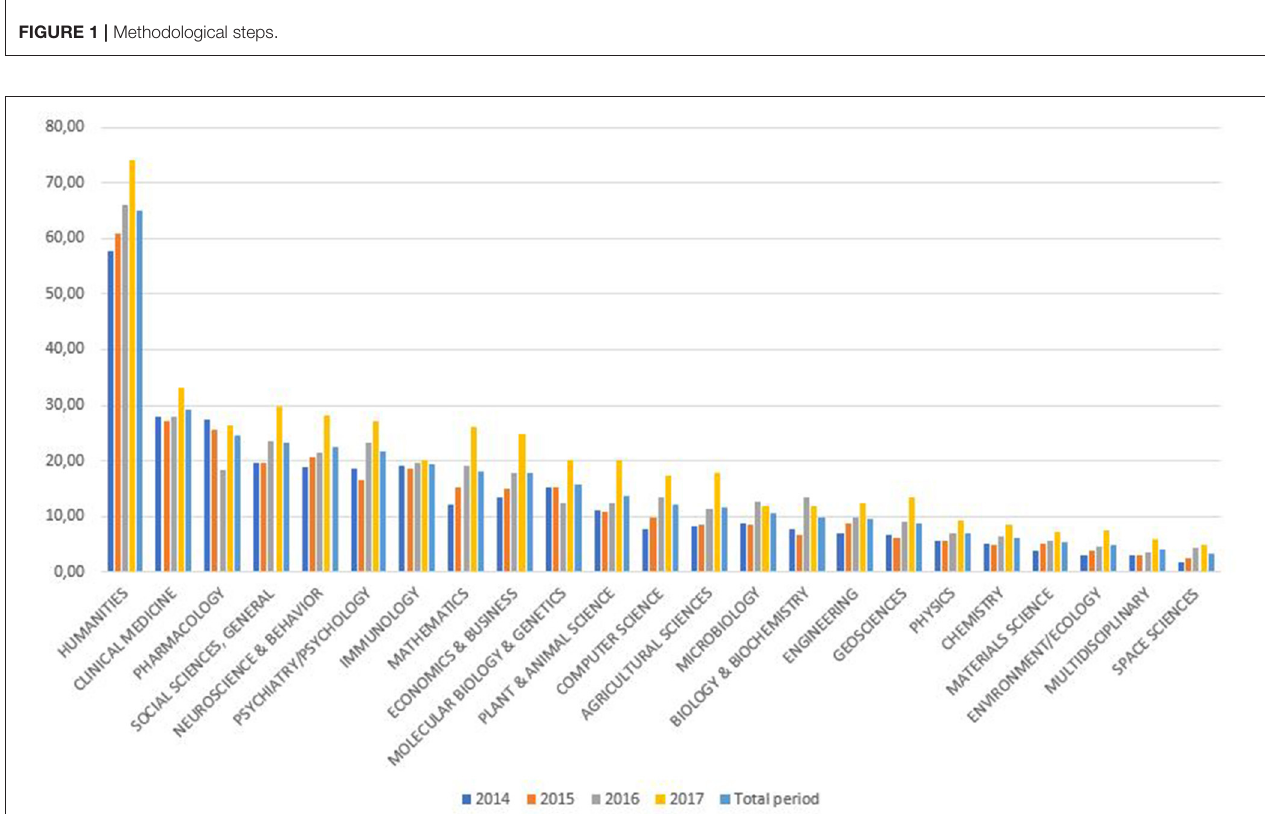
FIGURE 2 | Percentage of un-citedness in SUPE by Incites/Essential Science Indicators area.